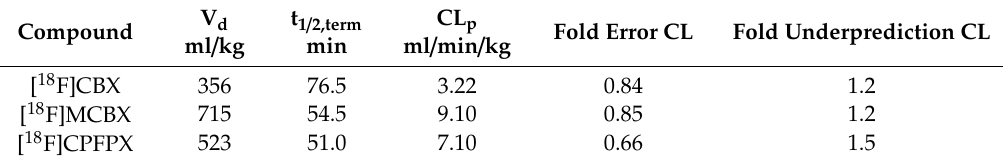
Figure 4. Time course of intact [ 18 F]CPFPX (triangles), [ 18 F]CBX (squares) and [ 18 F]MCBX (circles) in rat plasma. Dashed lines are a guide to the eye. Data (mean ± SD) were obtained from 8 ([ 18 F]CBX, [ 18 F]CPFPX) or 9 animals ([ 18 F]MCBX). Table 2. In vivo pharmacokinetic (PK) characteristics of the xanthine A 1 AR radiotracers following i.v. administration to rat and accuracy of in vitro–in vivo extrapolation. PK parameters were derived from mean plasma radioactivity-time curves generated from data of eight ([ 18 F]CBX, [ 18 F]CPFPX) or nine ([ 18 F]MCBX) animals.